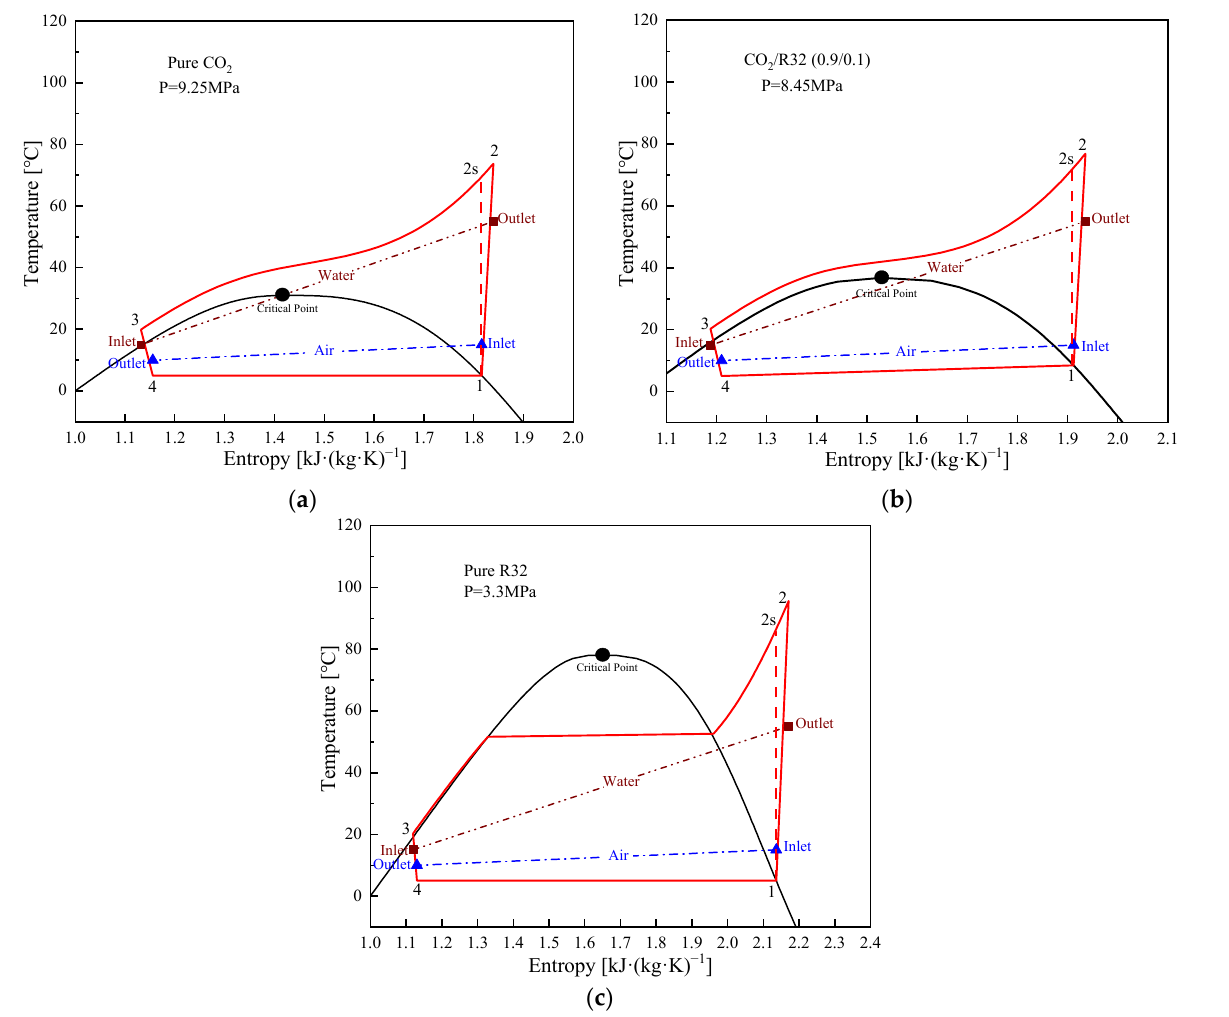
Figure 8. Temperature-entropy diagrams of the system cycle with ( a ) pure CO 2 refrigerant; ( b ) CO 2 /R32 mixture refrigerant; ( c ) pure R32 refrigerant.